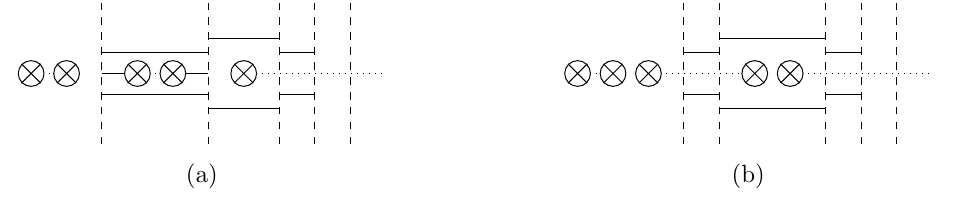
Figure 44. Brane realization of the C-collapse of partitions (3 ; 1) C = (2 2 ). (a) Has interval numbers for the half NS5-branes ~ k 0 = (0 ; 0 ; 1 ; 1 ; 2), corresponding to partition (cid:21) 0 = (3 ; 1). (b) Is obtained after performing the collapse transition on (a). The interval numbers of (b) are ~ k = (0 ; 0 ; 0 ; 2 ; 2), corresponding to partition (cid:21) = (2 2 ) = (cid:21) 0 . C